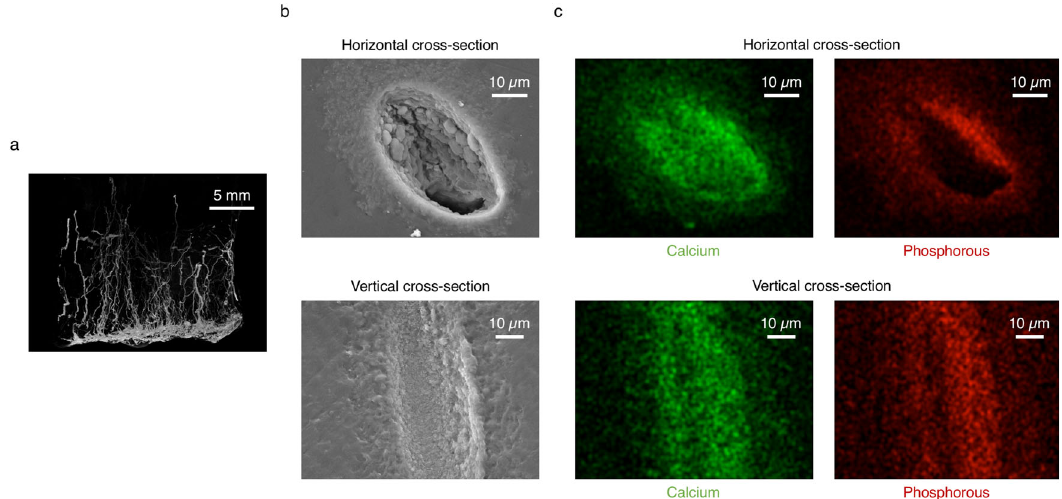
Fig. 4 Microstructural characterisation of chemobrionic composite. a Micro-computed tomography ( µ -CT) 3D reconstruction of a section of chemobrionic composite, which shows the alignment of calcium phosphate tubes encased within the poly(2-hydroxyethyl methacrylate) (pHEMA) matrix; scale bar = 5 mm. b Scanning electron microscopy (SEM) images of cross-sections of the chemobrionic composite along the horizontal and vertical planes, respectively, revealing intact tubular channels; scale bar = 10 µ m. c Energy dispersive X-ray (EDX) spectroscopy elemental mapping, with elemental calcium and phosphorous coloured green and red, respectively, con fi rming the channels were composed of calcium phosphate; scale bar = 10 µ